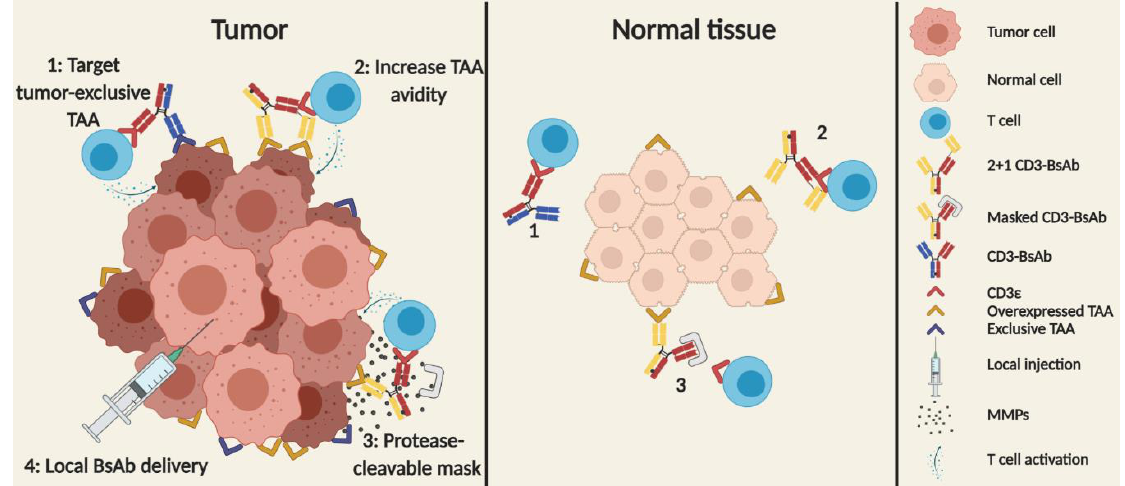
Figure 2. Solutions to mitigate hurdle 1: on-target off-tumor toxicities. ( 1 ) Target TAAs that are exclusively expressed by tumor cells, such as human leukocyte antigen (HLA)-presented neo-antigens, or surface antigens from virally induced cancers. ( 2 ) The avidity for TAAs can be increased with formats that include multiple TAA-binding arms. This results in increased selectivity for tumor targeting over healthy tissues. ( 3 ) Binding arms of CD3-BsAbs can be masked using a protease-cleavable linker, making the BsAb only active inside the tumor. In healthy tissues, a minimal presence of proteases limits unmasking of the CD3 arm, whereas the abundance of matrix metallopeptidases (MMPs) in the TME allows the CD3-BsAb to redirect T cells towards the tumor. ( 4 ) Ensure local delivery of CD3-BsAbs to decrease systemic exposure by either local injection, or using delivery systems that locally produce these BsAbs, such as oncolytic viruses (OVs) and STAb-T cells.